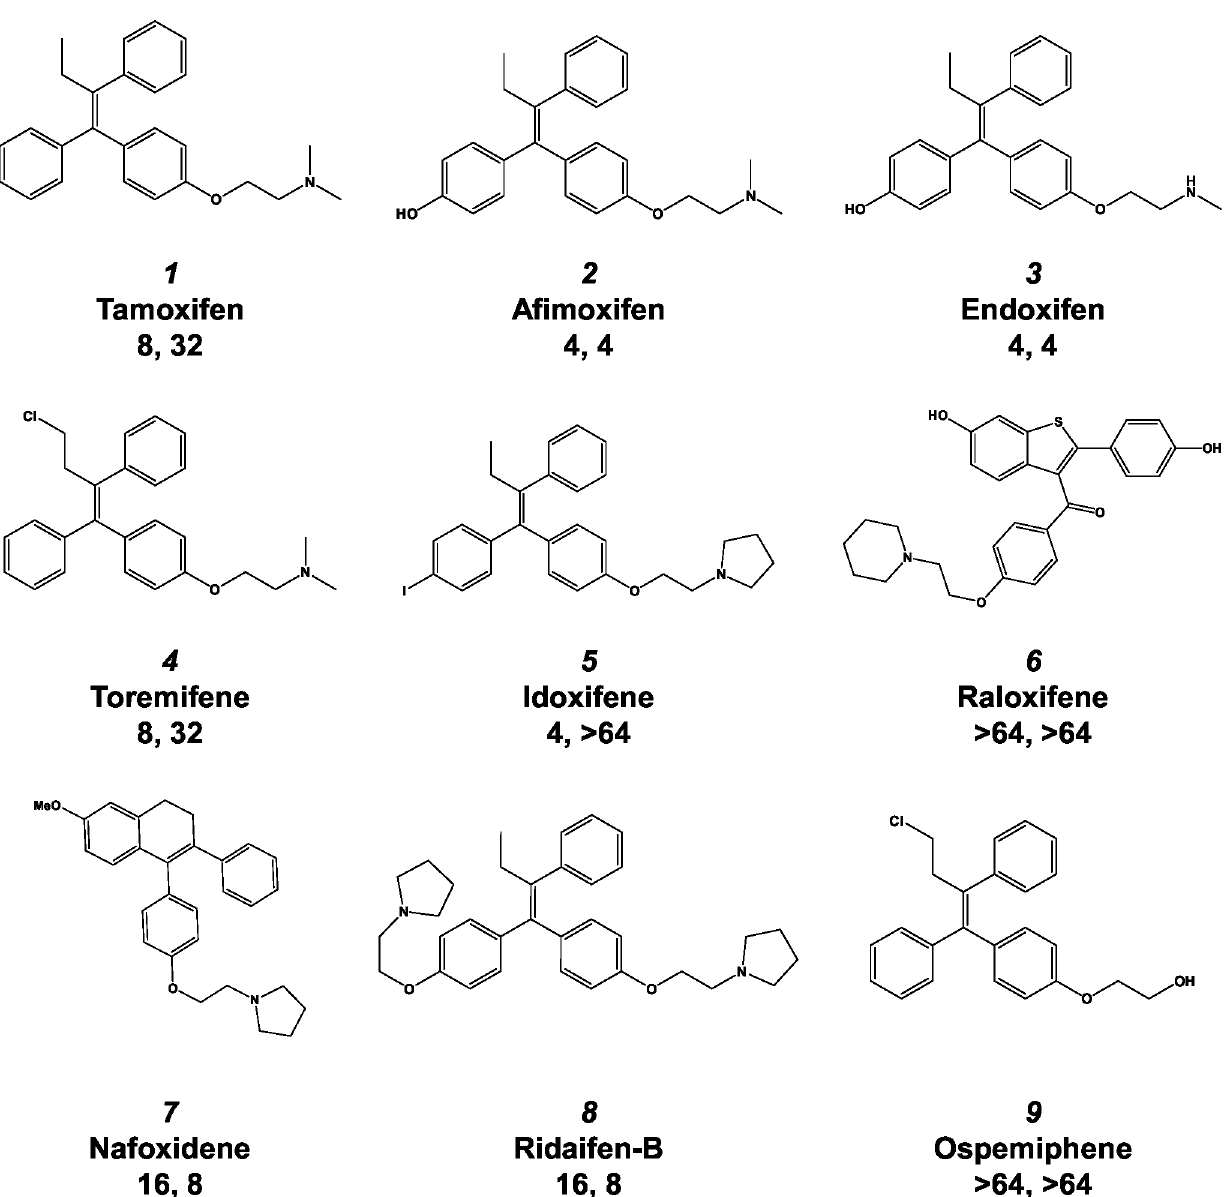
Fig 2. Activity of commercially available SERM against C . neoformans and C . albicans . The structure, molecule number used in the text, name, minimum inhibitory concentration (MIC, μ g/mL) against C . neoformans (first number) and MIC against C . albicans are